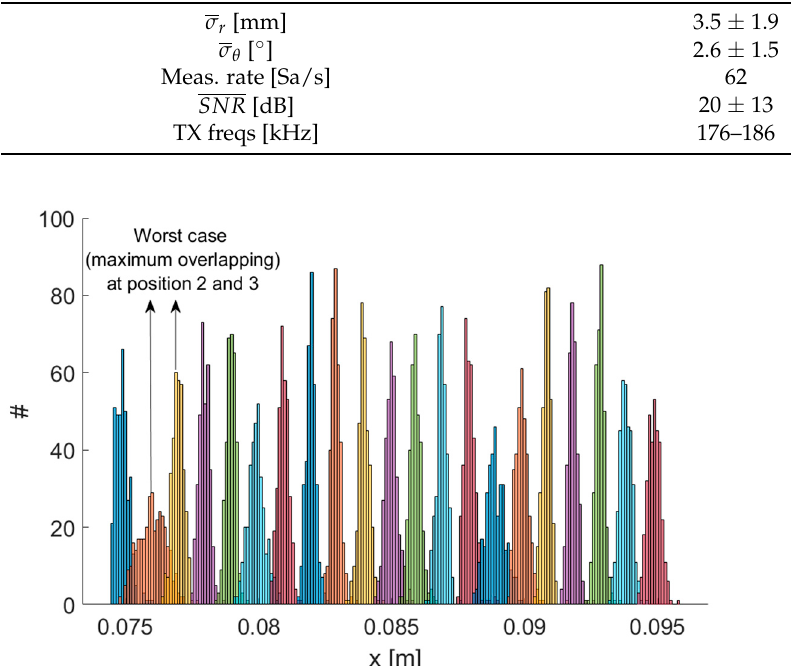
Figure 2. Testing the resolution of the MPS. Repeated measurement results on a set of positions spaced 1 mm. Maximum overlapping has been obtained for positions 2 and 3.